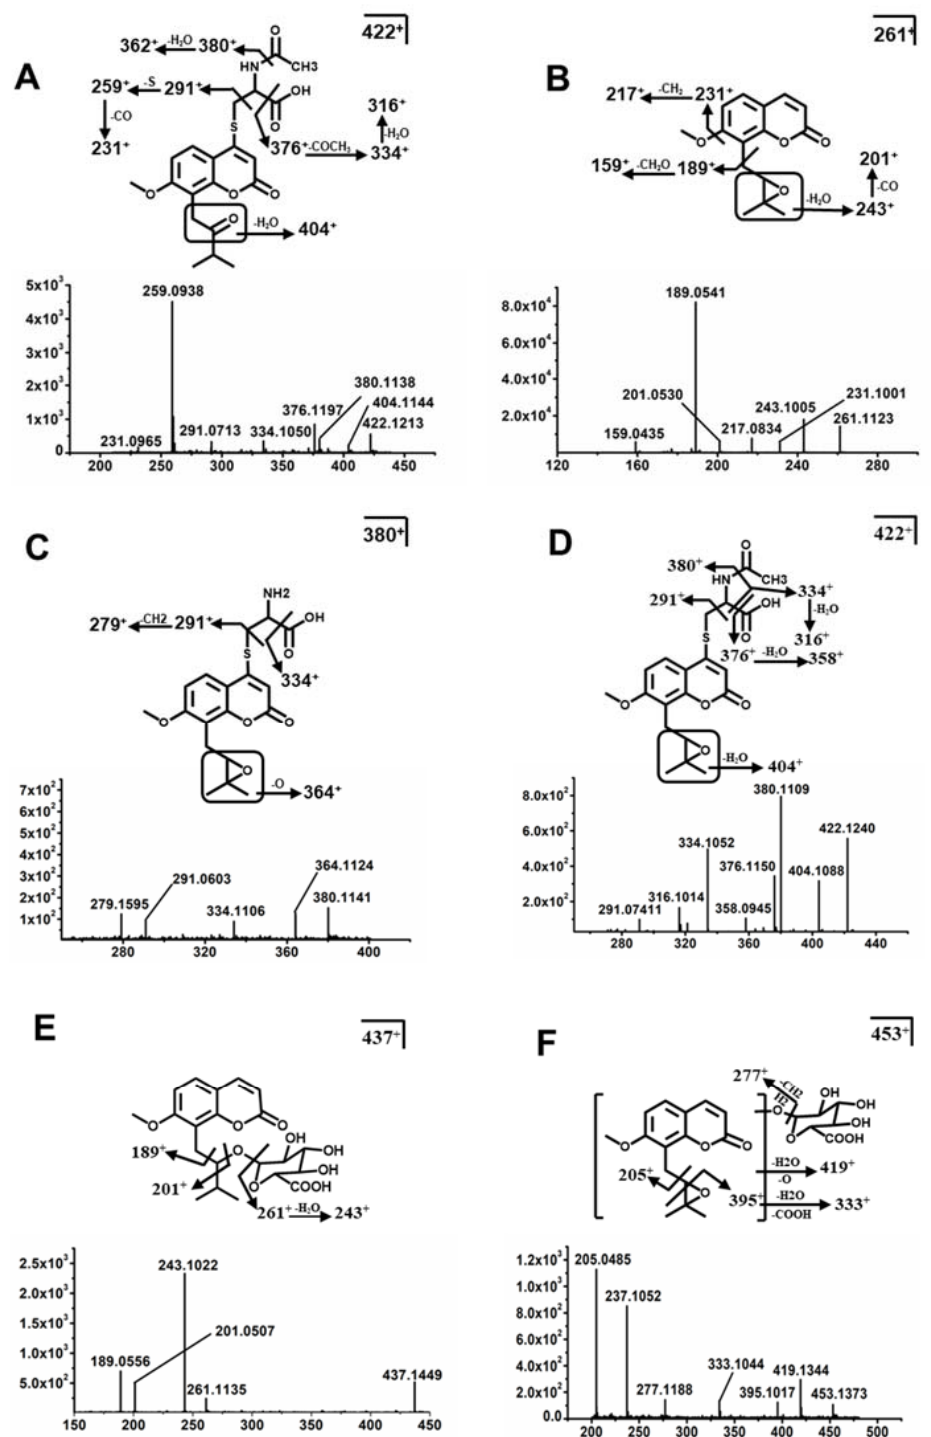
Figure 6. Typical MS/MS fragments of ISM and MER metabolites. MS/MS fragment and structures of Mi10/Mi10a ( A ). MS/MS fragment and structures of Me0 ( B ), Me9/Me9a ( C ). Me10/Me10a ( D ), Me11 ( E ), and Me12 ( F ).